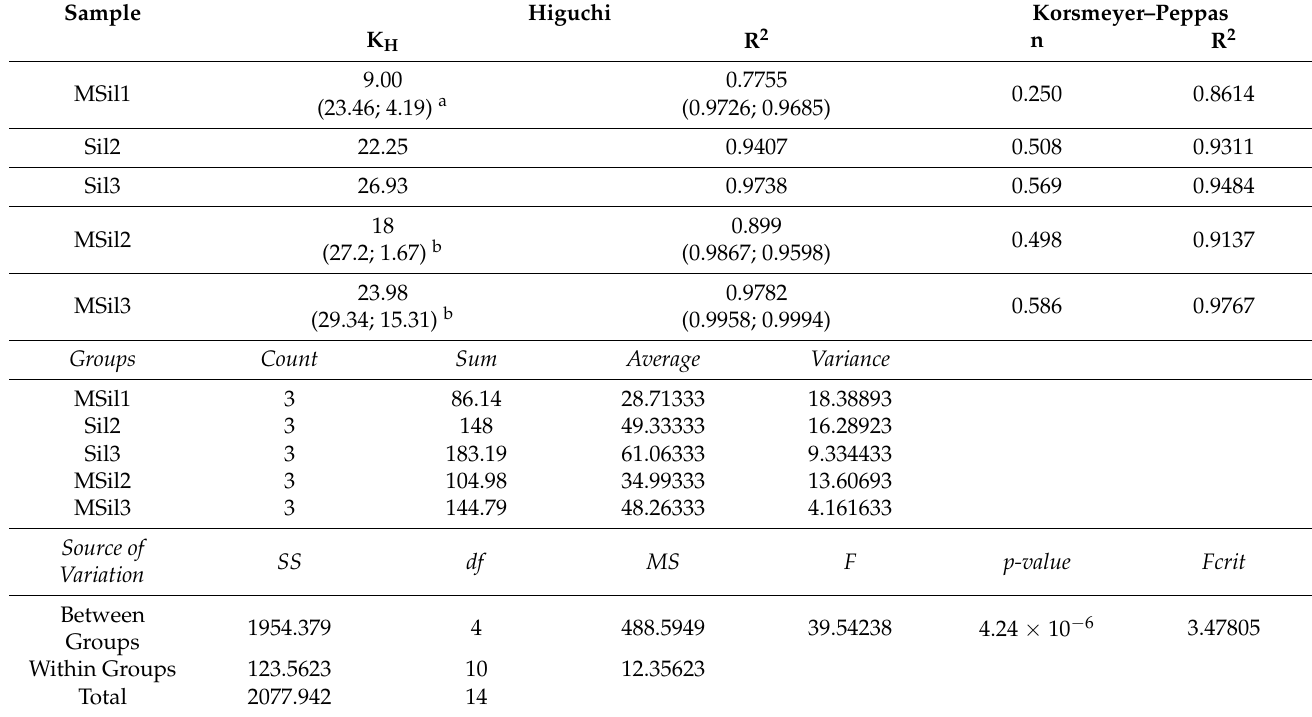
Table 8. Kinetics of Dox Release and analysis of variance (ANOVA) in pH =